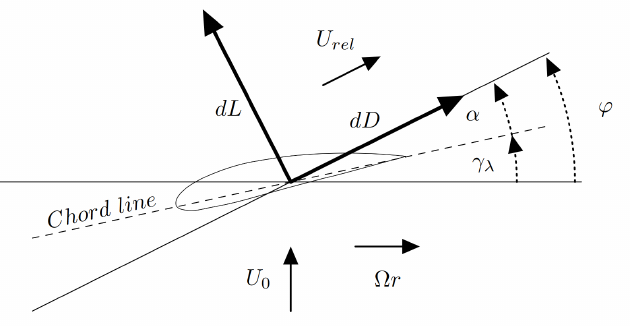
Figure 15. Figure 12 Subdivision of Loads on blade airfoil